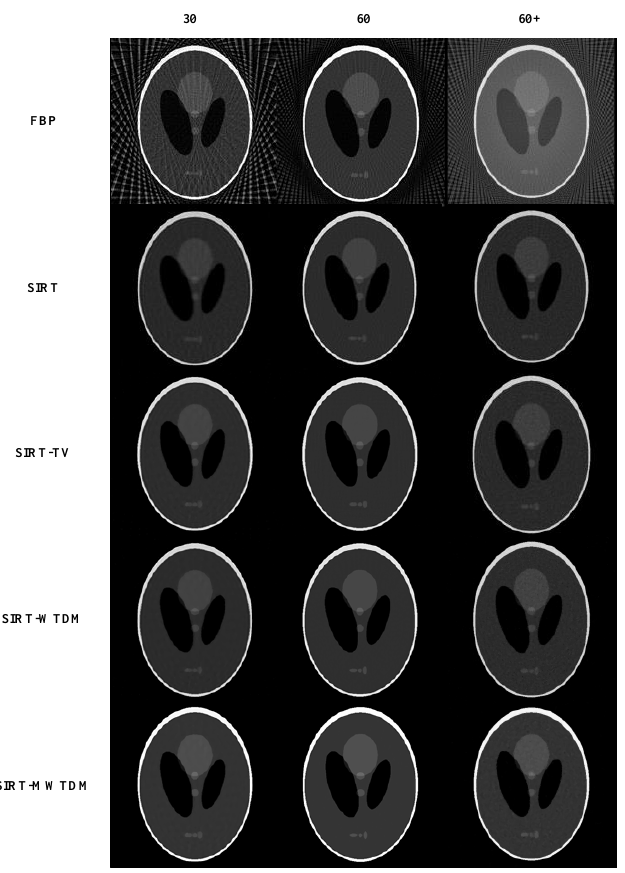
Figure 3. Reconstructed results of the Shepp–Logan phantom obtained by using different algorithms with different numbers of projections. Images from left to right show reconstructed results from 30, 60, and 60+ projections, respectively. Here, 60+ indicates that Poisson noise is added to 60 projections. Rows from top to bottom are reconstructed by using FBP, SIRT, SIRT-TV, SIRT-WTDM, and SIRT-MWTDM, respectively.